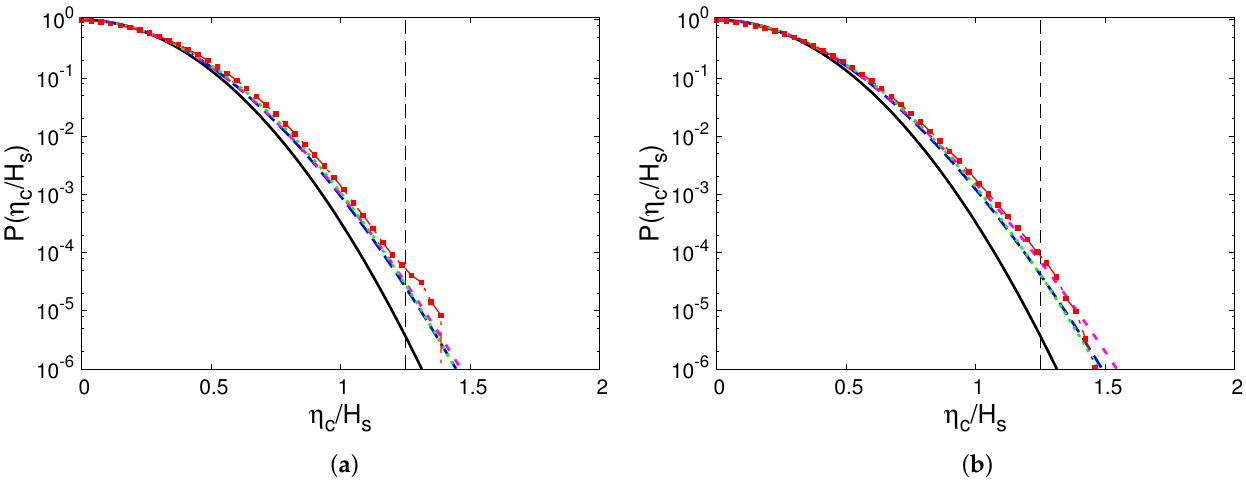
Figure 6. Exceedance probability of crest heights normalized with H s , P ( ζ ) = Pr [ η c /H s > ζ ] . ( a ) case #16, ( b ) case #4. Black solid line — Rayleigh distribution, blue dashed line −− Tayfun second order distribution, magenta short dashed line - - Tayfun third order distribution, green dotted line · · · Forristall distribution, red squares (cid:0) HOS simulation. The vertical line at η c /H s = 1.25 represents the threshold to identify extreme